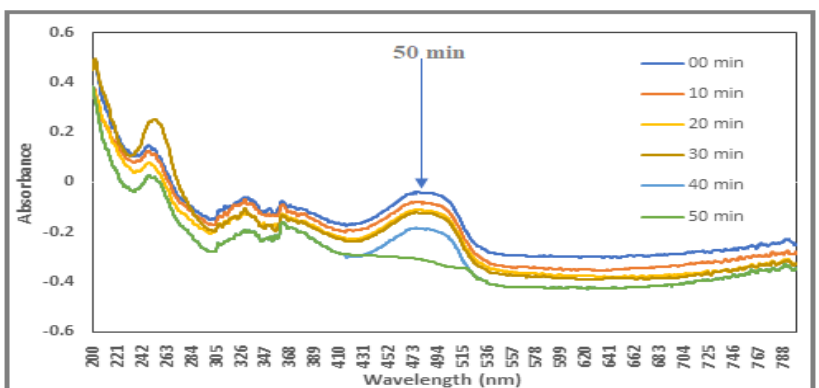
O @ZnO@MgO Core-shell nanoparticles with UV 2 4